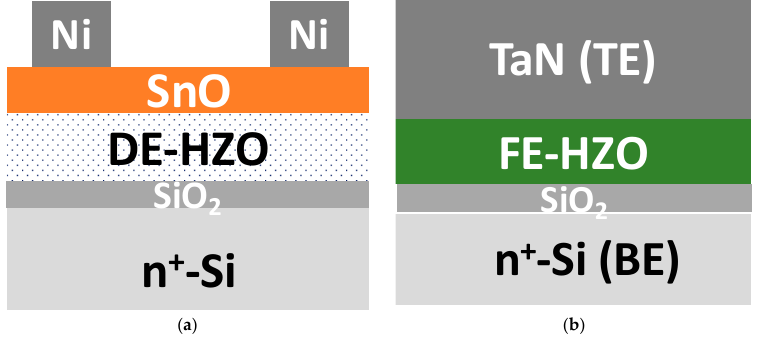
Figure 2. Schematic plots of ( a ) a p-type SnO TFT and ( b ) a ferroelectric HZO MFM capacitor.